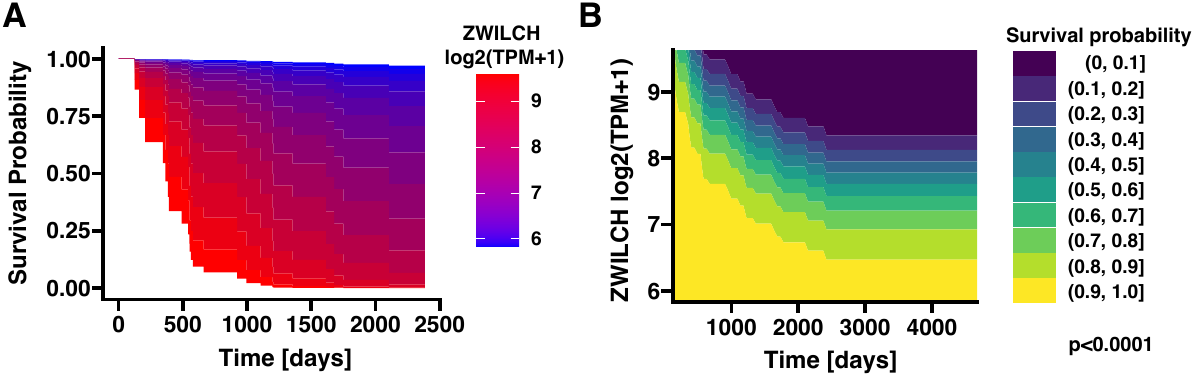
Figure 1. An overall survival area plot showing different estimates of the causal effect of the ZWILCH expression on survival using different Cox proportional hazards regression models ( A ). The contour plot illustrates the probability of patient survival over time according to ZWILCH gene expression level in ACC patients from the TCGA database ( B